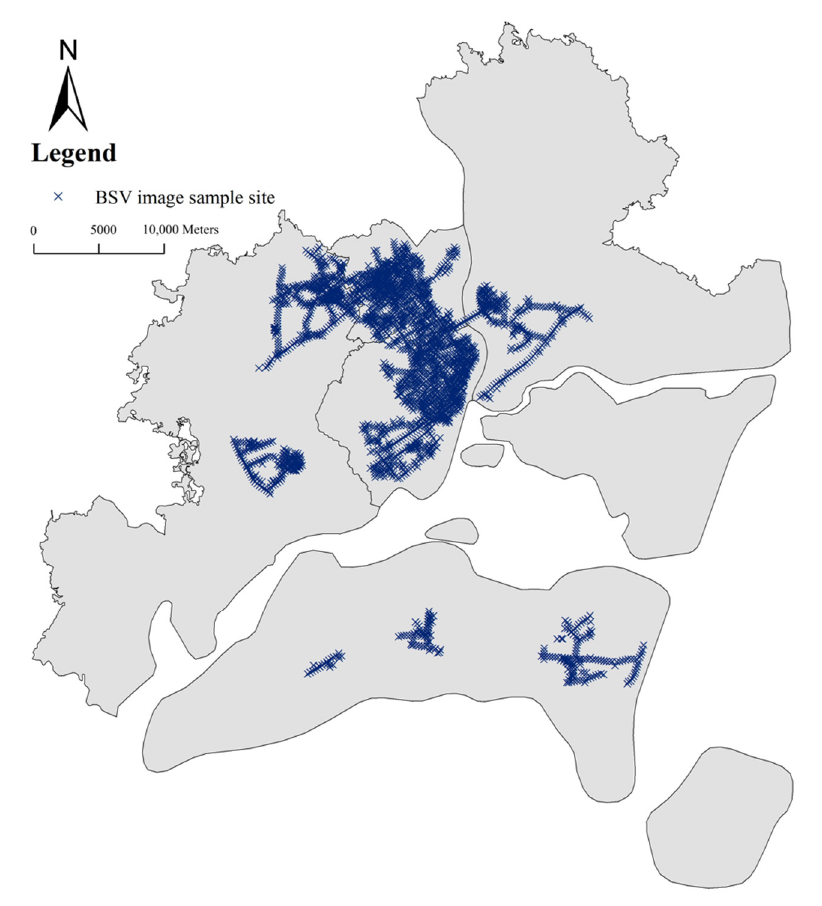
Figure 2. The sample sites of BSV image .